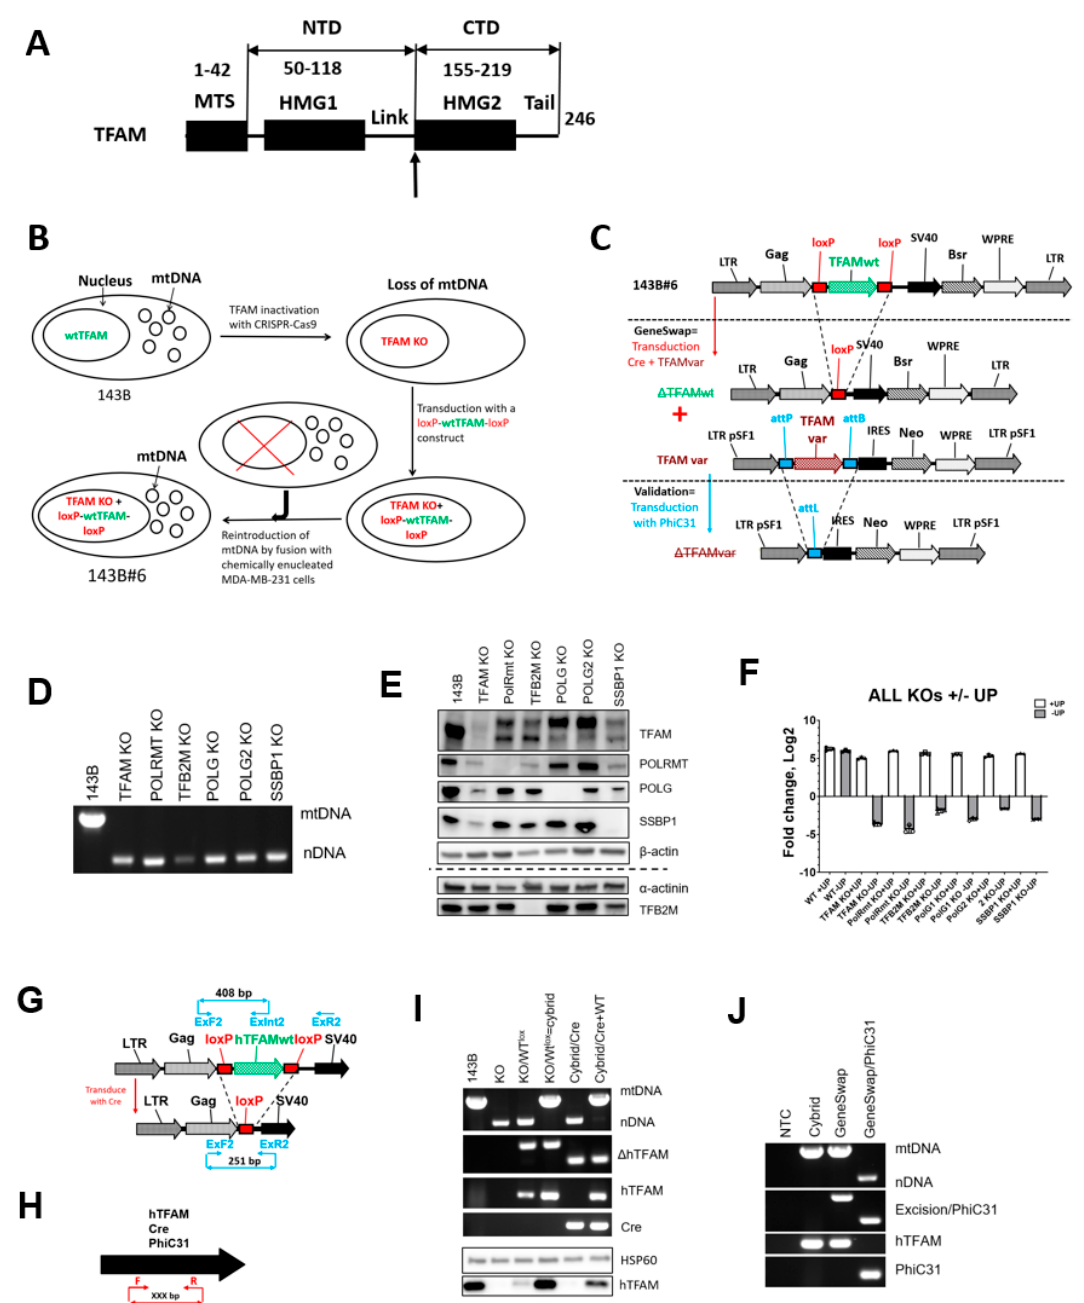
Figure 1. The domain structure of the human TFAM and a general outline of the GeneSwap approach. ( A ), Upward vertical arrow, a crossover point in chimeras. Here, we refer to the TFAM portion preceding the crossover point as N-terminal domain (NTD), and the portion following HMG2 as C-terminal domain (CTD). Domain boundaries are given in aa coordinates. MTS, matrix targeting sequence, Link, linker region. ( B ), Engineering of a GeneSwap cell line using TFAM GeneSwap